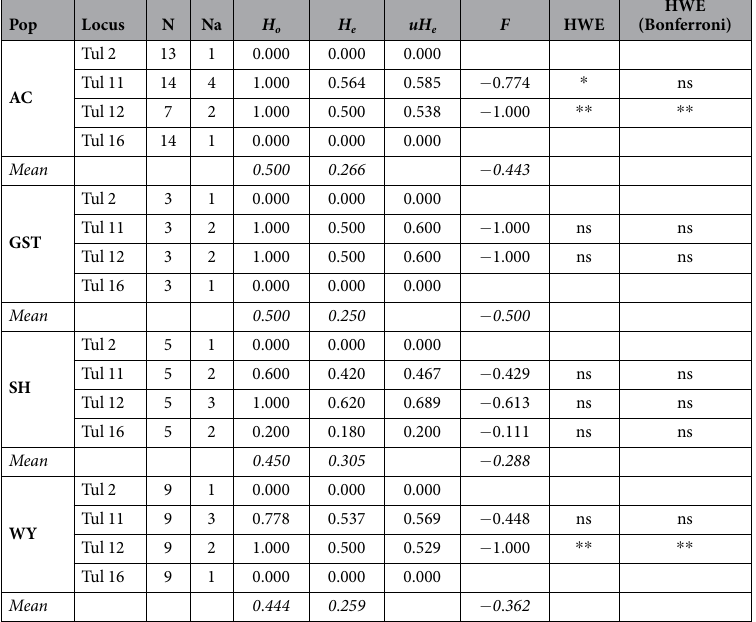
Table 5. Measures of SSR diversity for Tulasnella sphagneti sampled at Kosciuszko National Park: Number of isolates (N), number of alleles ( Na ), observed heterozygosity ( H o ), expected heterozygosity ( H e ), unbiased expected heterozygosity ( uH e ), fixation index ( F ) and significance for Hardy-Weinberg equilibrium before and after Bonferroni correction. Key: ns = not significant, * P < 0.05, ** P < 0.01, *** P < 0.001.